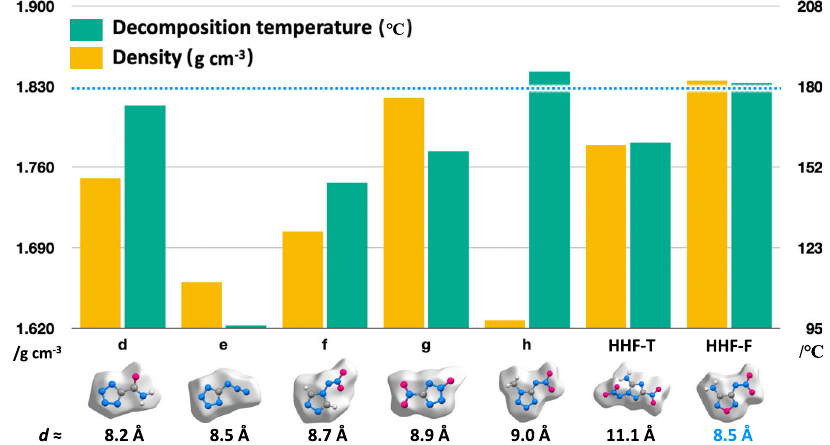
Fig. 3 | Density and decomposition temperature comparison of HHF-F with other hydroxylammonium salts. Decomposition temperature (green bar) and crystal density (yellow bar) comparison of HHF-F with HHF-T and